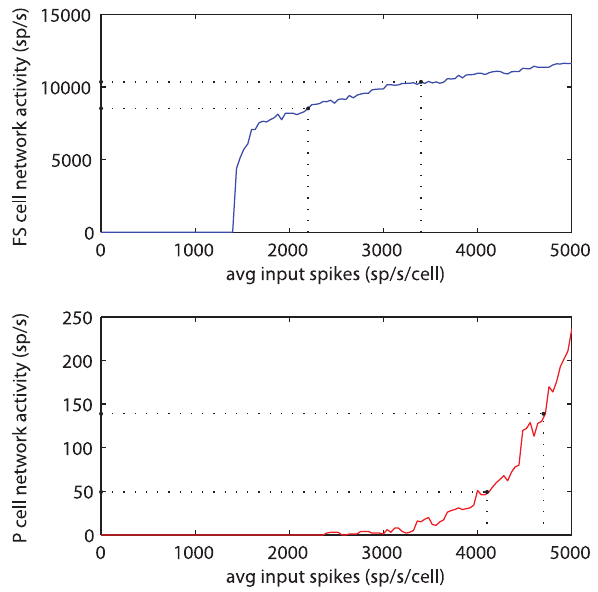
Figure 5. Frequency/input curves for the two model subnet- works: the fast-spiking cells (top) and the pyramidal cells (bottom). The dotted lines perpendicular to the x-axis represent the total range of spike train input experienced by the subnetworks due to the theta-modulated input fibres. Dotted lines perpendicular to the y- axis represent the resulting subnetwork spike activity. While the theta- modulation of input spikes is stronger for the FS cells than for the P cells, the resulting difference in subnetwork spike activity is greater for the P cells, as can be observed from the intersection of the horizontal lines with the